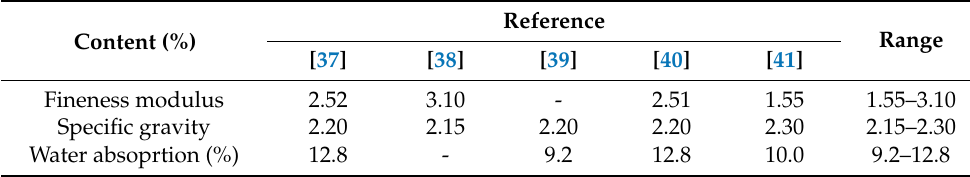
Table 1. Physical properties of MSWI-BA from the selected literature